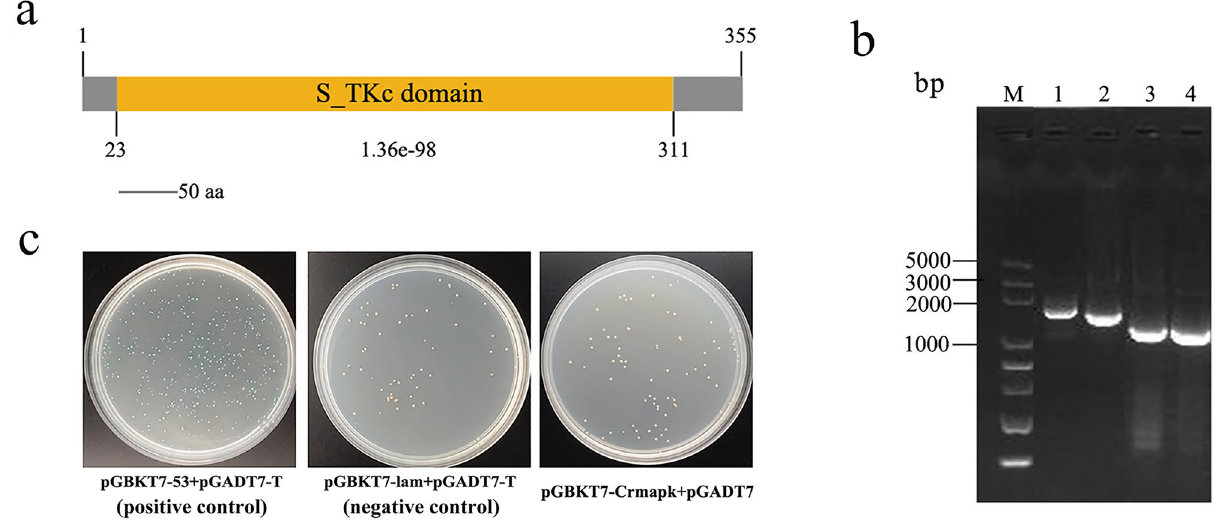
Figure 2. Construction of pGBKT7-Crmapk bait vector in C. chloroleuca 67-1. ( a ) Domain structure of Crmapk as annotated by SMART (http:// smart. embl. de/). ( b ) Verification of the recombinant pGBKT7-Crmapk bait vector. M, DNA 5000 markers; Lanes 1–2, verification of the pGBKT7-Crmapk bait vector using vector primers T7/3 ′ BD; Lanes 3–4, verification of the bait vector using target gene primers Crmapk-F/Crmapk-R. ( c ) Self-activation tests of the pGBKT7-Crmapk bait vector. The bait and empty vector pGADT7 were transformed into the Y2H Gold strain and cultured on SD/-Trp/X medium. pGBKT7-p53 and pGADT7-T were used together as a positive control, while pGBKT7-Lam and pGADT7-T served as a negative